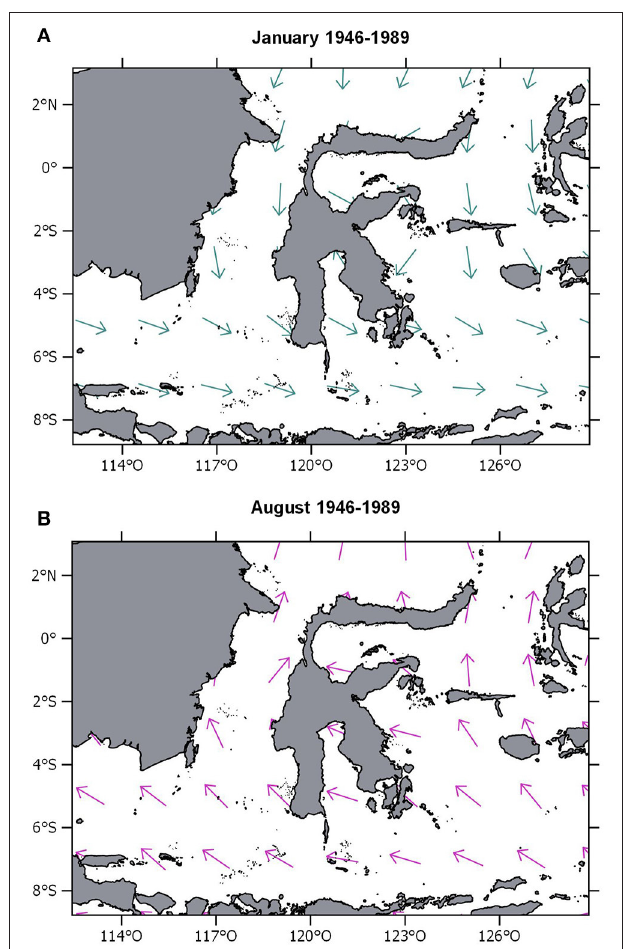
FIGURE 2 | (A) Map of Sulawesi with monsoon winds toward east-southeast during wet season (mean wind direction January 1946–1989). (B) Map of Sulawesi with monsoon winds toward north-northwest during dry season (mean wind direction August 1946–1989). Wind data derived from COADS Monthly Climatology dataset (Woodruff et al.,